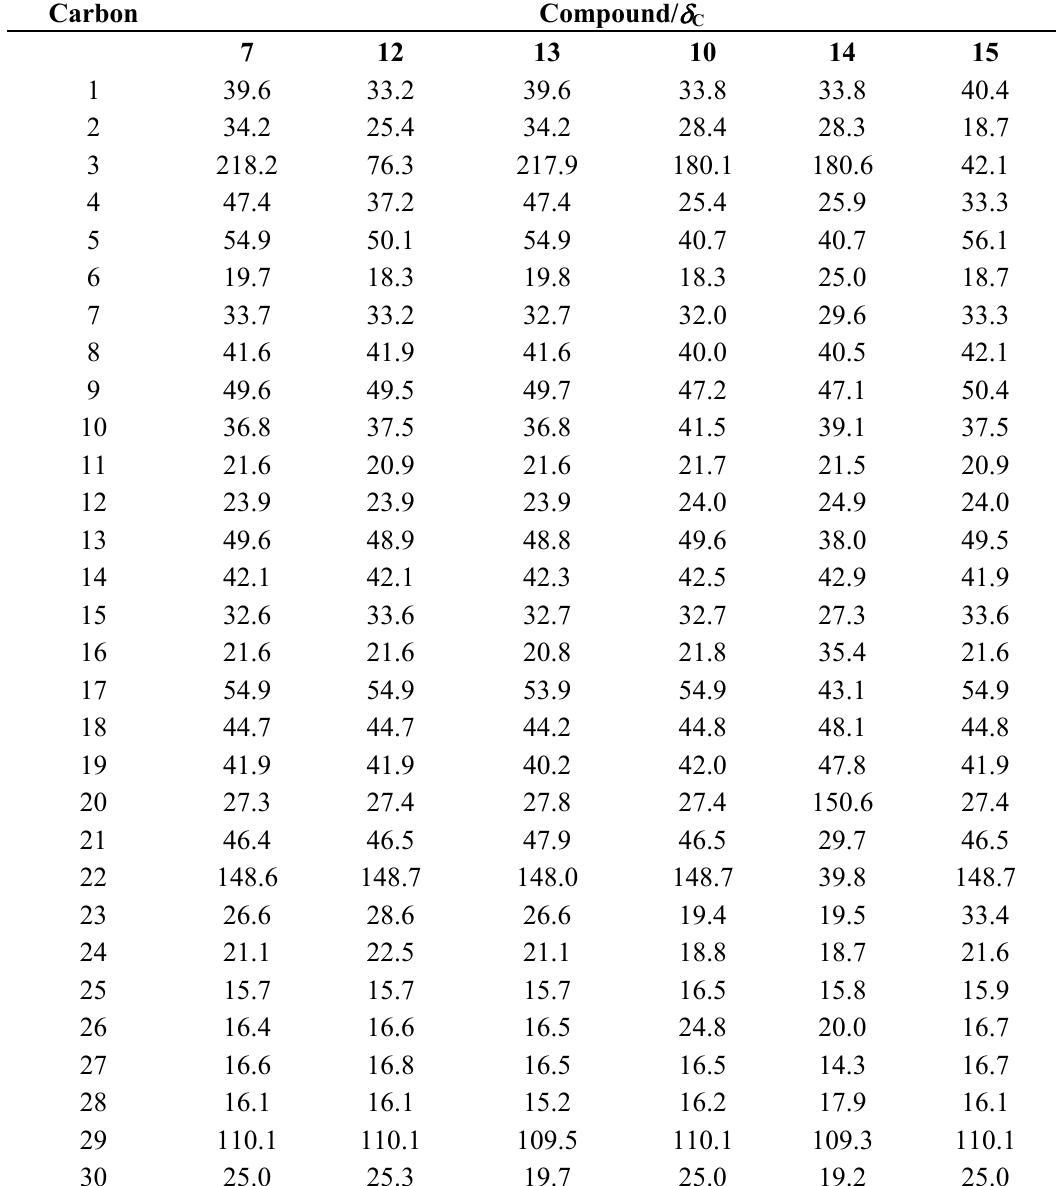
Table 1. 13 C-NMR data of triterpene 7 , compared with the corresponding data described in the literature for 12 [26] and 13 [27], and 13 C-NMR data of triterpene 10 , compared with the corresponding data described in the literature for 14 [28] and 15